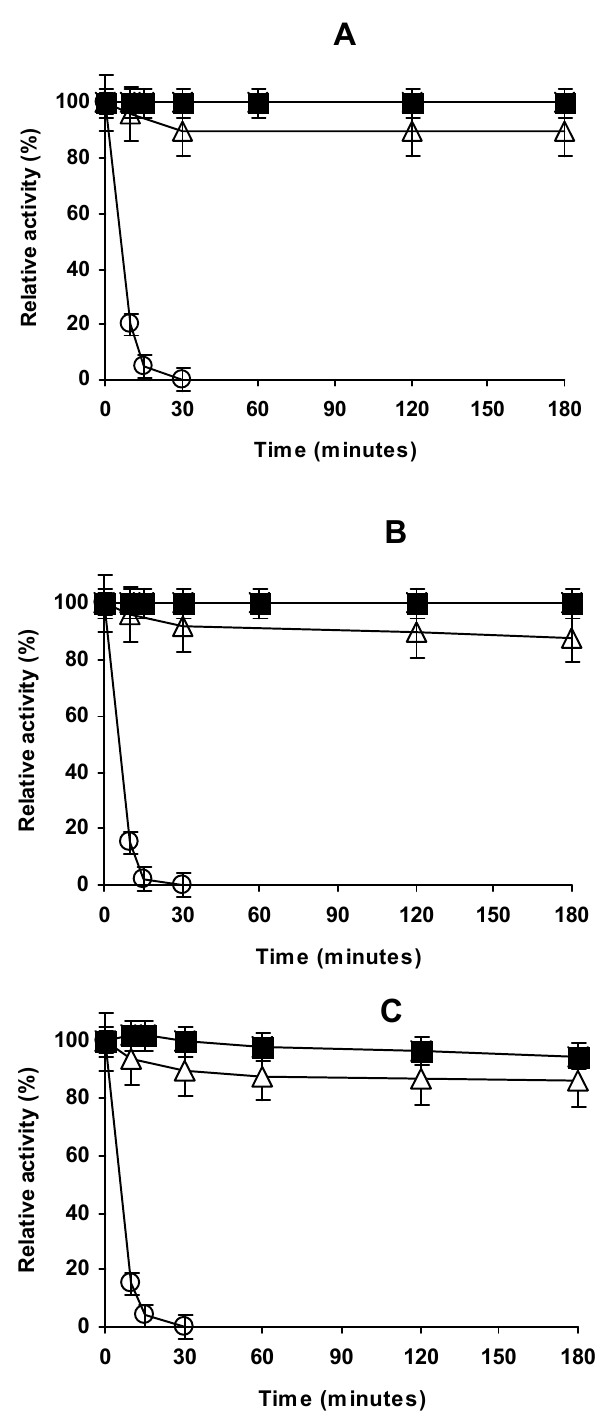
Figure 1. Immobilization courses of β -gal on MANAE-agarose beads at: ( A ) pH 5; ( B ) pH 7; and ( C ) pH 9. Immobilization was performed at 25 ◦ C using 5 mM sodium acetate, sodium phosphate or sodium bicarbonate, respectively, as described in Methods Section. A support having 60 µ mol MANAE groups/g of support was utilized. All experiments were performed in triplicate and the values are given as mean value ± the experimental error. Other specifications are described in Methods Section. Squares: Reference; Triangles: immobilization suspension; and Circles: immobilization supernatant.